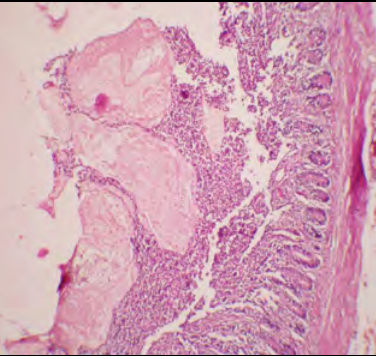
Figure-7. Intestine: Necrotic enteritis characterized by presence of necrotic mass along with desquamated epithelial cells and leucocytes in the lumen ( Salmonella Gallinarum infection) H & E x